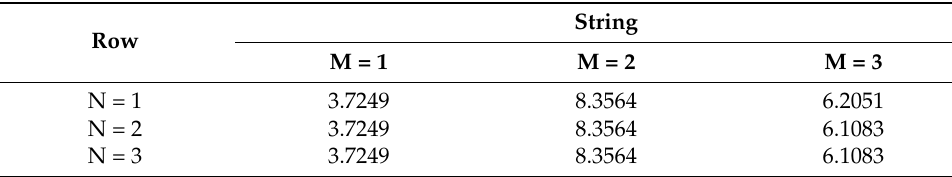
Table 4. I ph currents of the experimental 3 × 3 array.